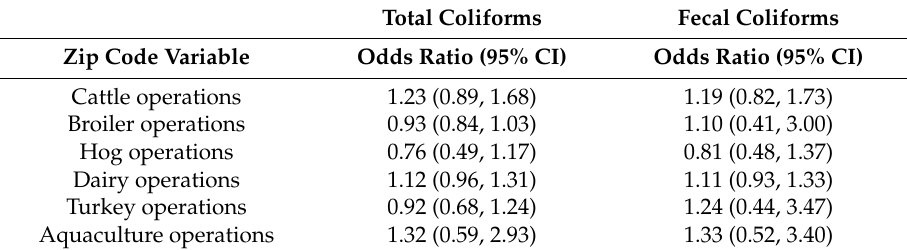
Table 3. Zip code-level analysis of the association between the presence of animal feeding operations and the occurrence of total and fecal coliforms in tested